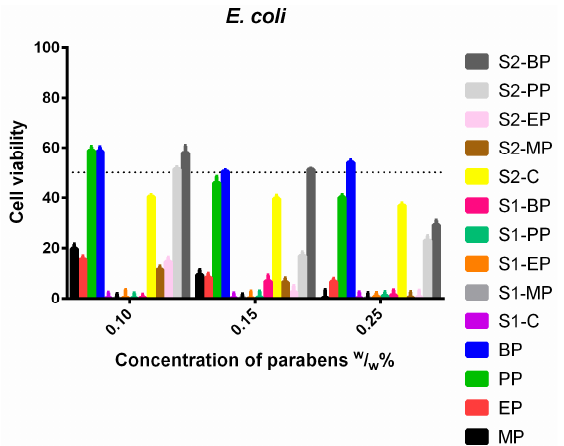
Figure 12. Cell viability of E. coli against the control paraben solutions (MP; EP; PP; BP); the first system (S1-MP; S1-EP; S1-PP; S1-BP) and the second system (S2-MP; S2-EP; S2-PP; S2-BP). Cell